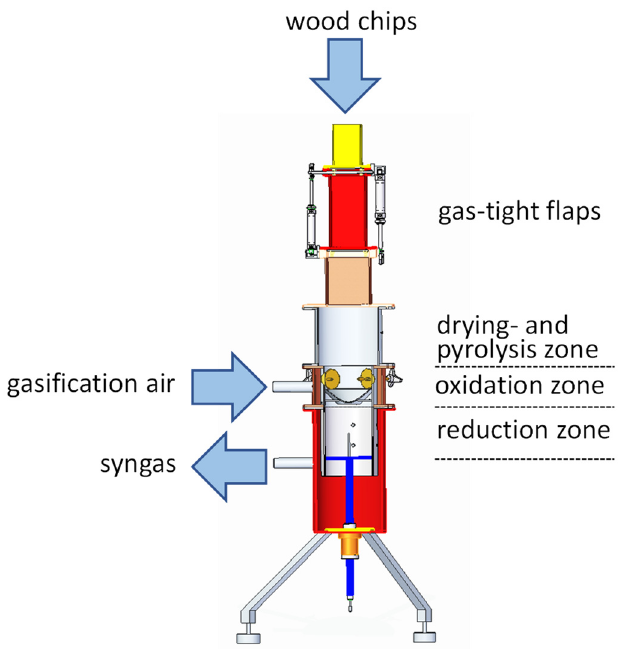
Figure 5. Schematic illustration of the down draft fixed-feed gasifier (nominal power output: 60 kW). The gasifier was placed on a set of scales for weight monitoring (not shown), and was fueled by wood chips.